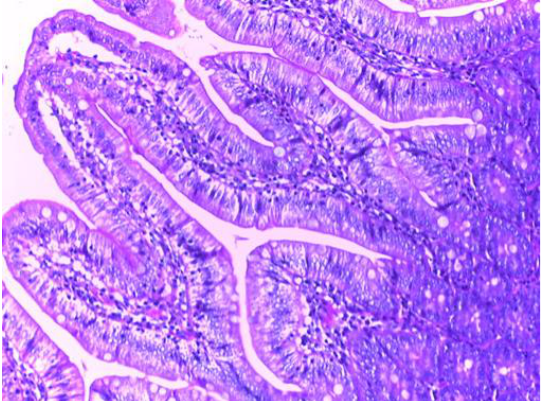
Figure 11. Histological examination of group III (H&E stain, 10X ( A ); 40X ( B )).